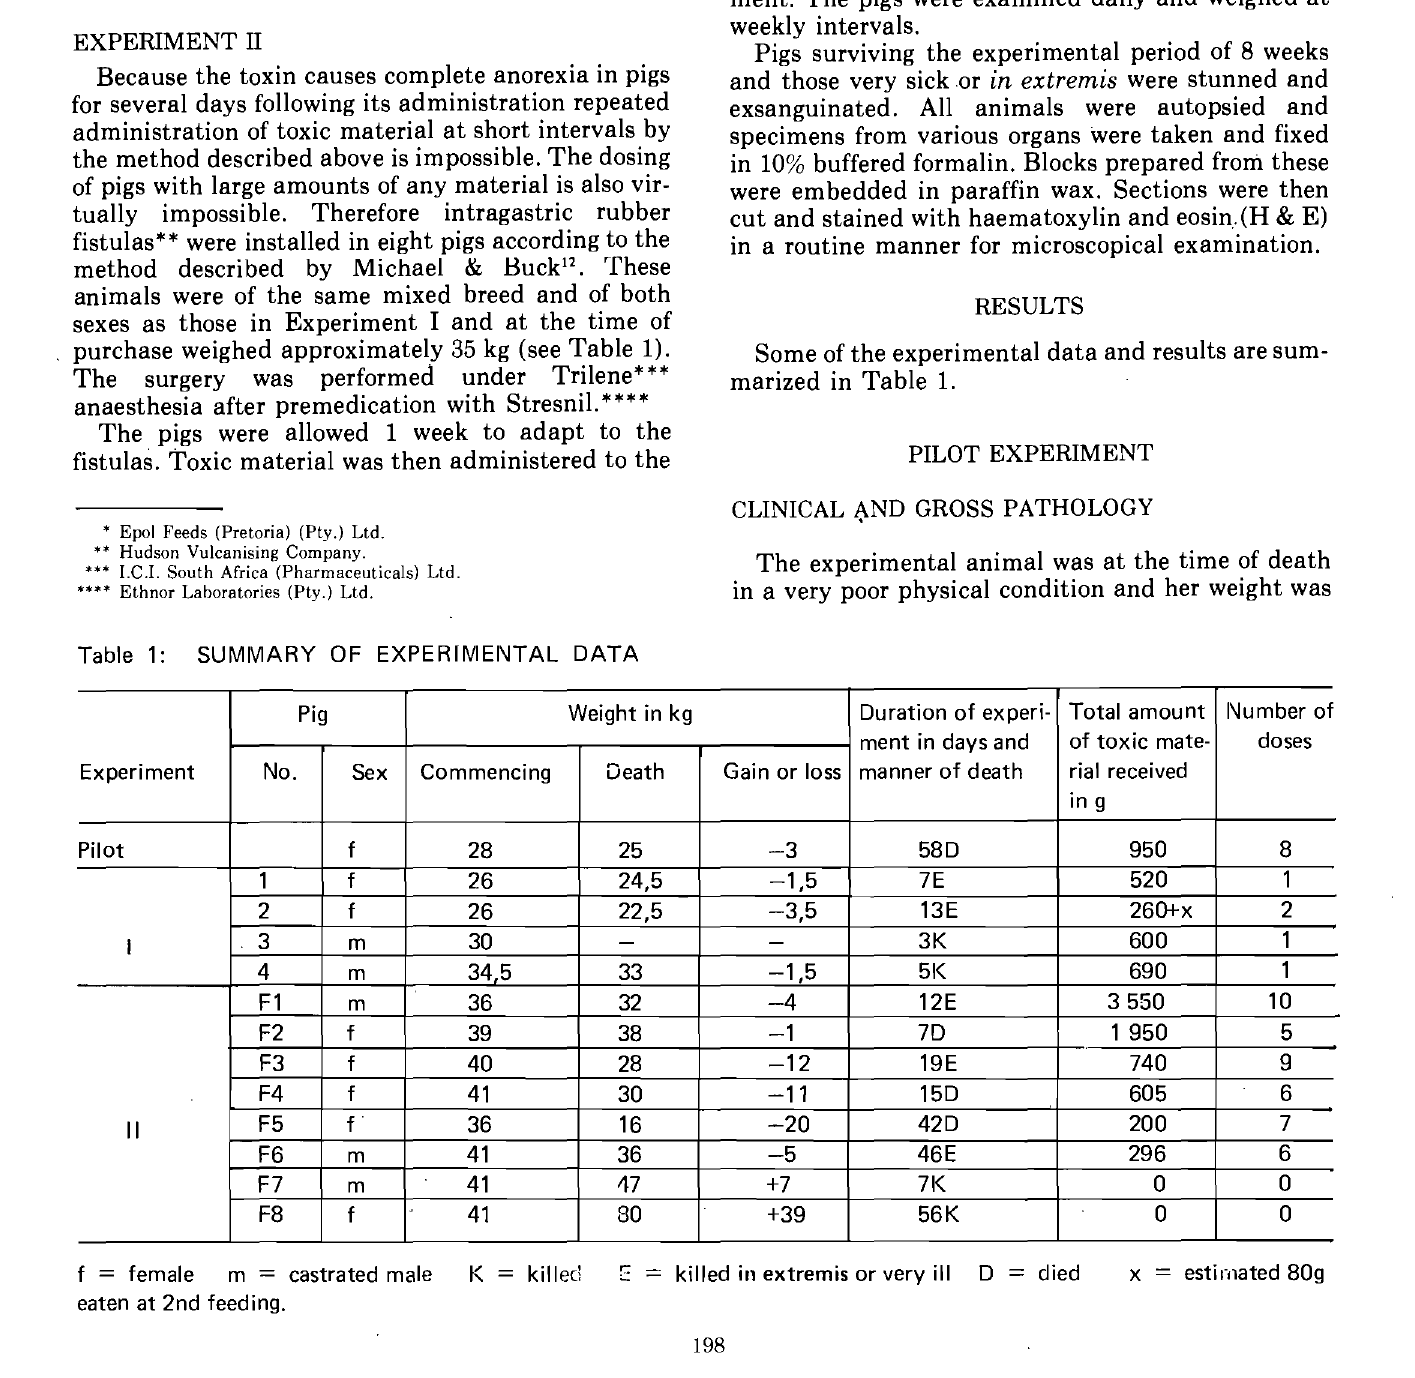
SUMIVIARY OF EXPERIMEI\lTAL DATA Pig Weight in kg Experiment No. Sex